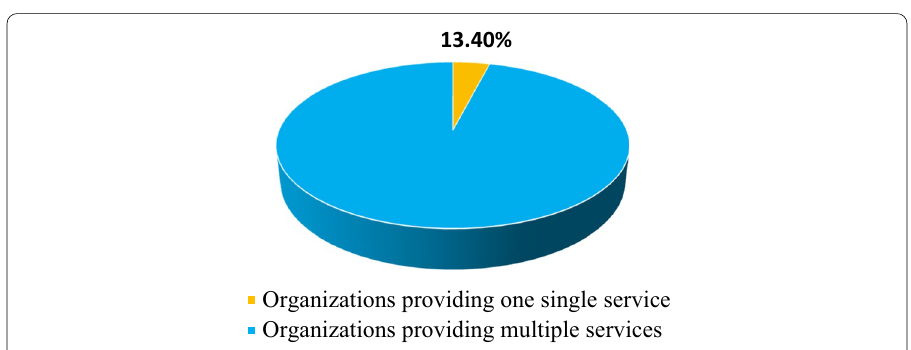
Fig. 11 Percentages of the two categories: organizations providing one single service, and organizations providing multiple